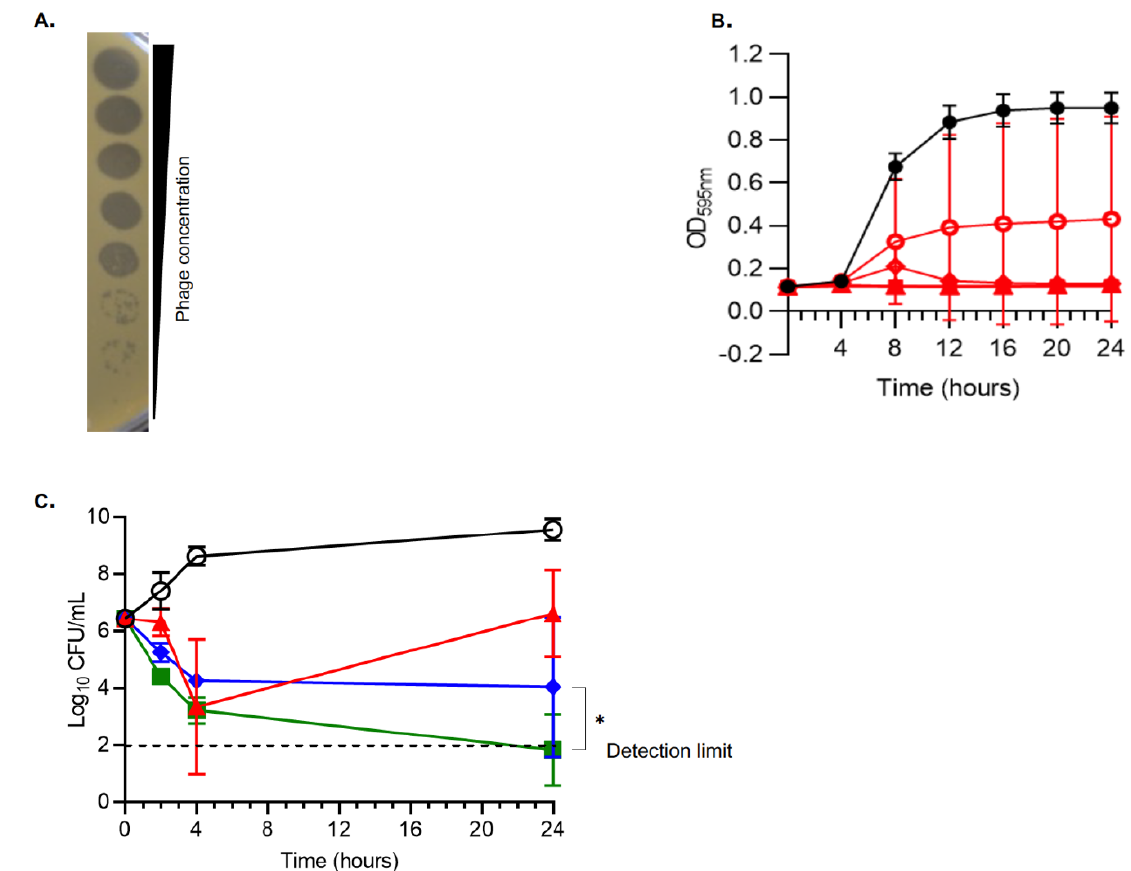
Figure 1. In vitro activity of the phage cocktail against MRSA AW7. ( A ) Diluted drop tests; ( B ) Turbidity assays; ( C ). Time-kill assays in absence and presence of vancomycin. ( A ) The phage cocktail was serially 10-fold diluted from top to bottom (starting concentration was 10 10 PFU/mL). ( B ) Control without phages (closed black circles); phages at MOI = 0.01 (open red circles), MOI = 0.1 (open red diamonds), MOI = 1 (open red triangles), MOI = 10 (closed red squares), and MOI = 100 (closed red triangles). ( C) Time-kill assays were performed by challenging MRSA AW7 with saline (open black circles); phage cocktail at MOI = 1 (closed red triangles), vancomycin at 2×MIC (closed blue diamonds), or a combination of both treatments (closed green squares). Means (±SD) of three independent experiments performed in triplicate are shown in panels B and C. One-way ANOVA with Tukey correction for multiple comparison statistical tests were performed to compare either areas under the curves of curves obtained at MOI = 0.1 (Figure 1B) or 24 h time-points (Figure 1C). CFU, colony forming unit; MIC, minimum inhibitory concentration; MOI, multiplicity of infection; PFU, plaque forming unit. * p < 0.05.